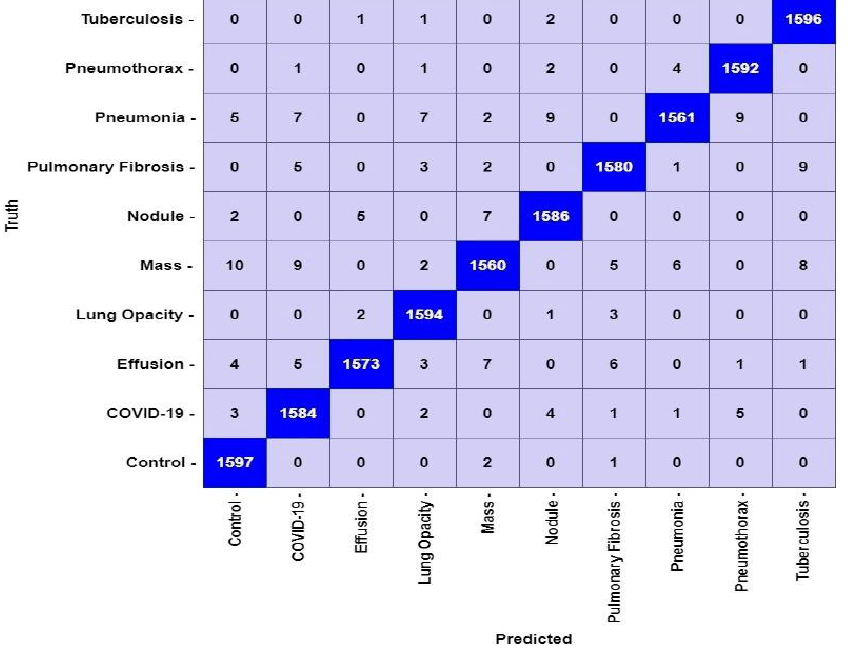
Figure 12. Confusion matrix for LungNet22 model.